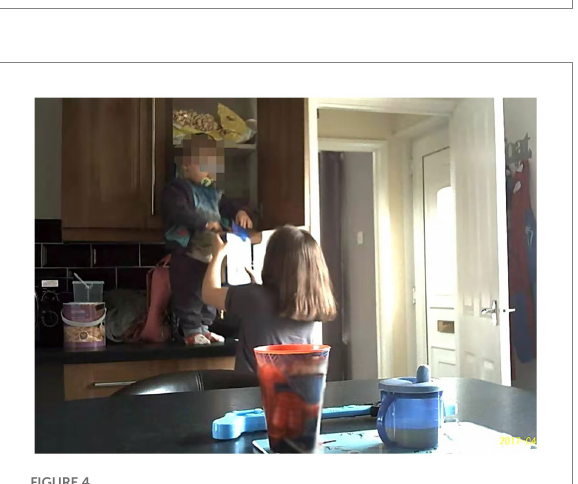
FIGURE 1 MUd05 (left panel) and MU01 (middle and right) using child-sized bowls, cups and pre-packaged snacks for children (MUd05D:25 m; MU01S1:48 m).